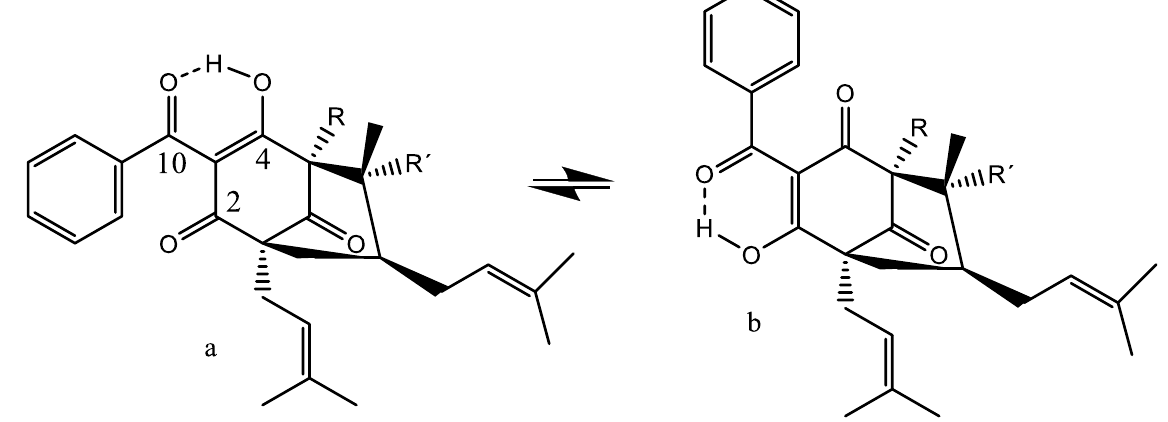
Figure 18. Tautomerism between the ( a , b ) forms. Structures of R,R (cid:48) = H, garciniaphenone and R = prenyl, R (cid:48) = H, 7- epi